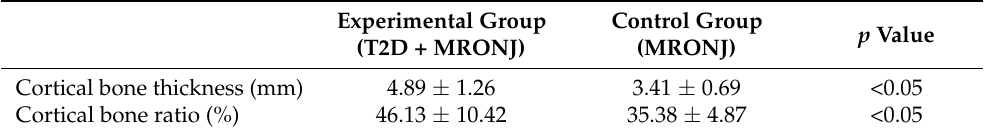
Table 3. Cortical bone thickness (mm) and ratio (%) in patients.